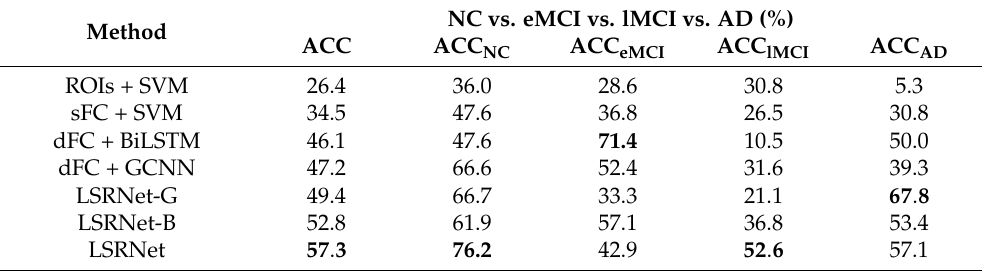
Table 3. Performance of all methods on four classifications